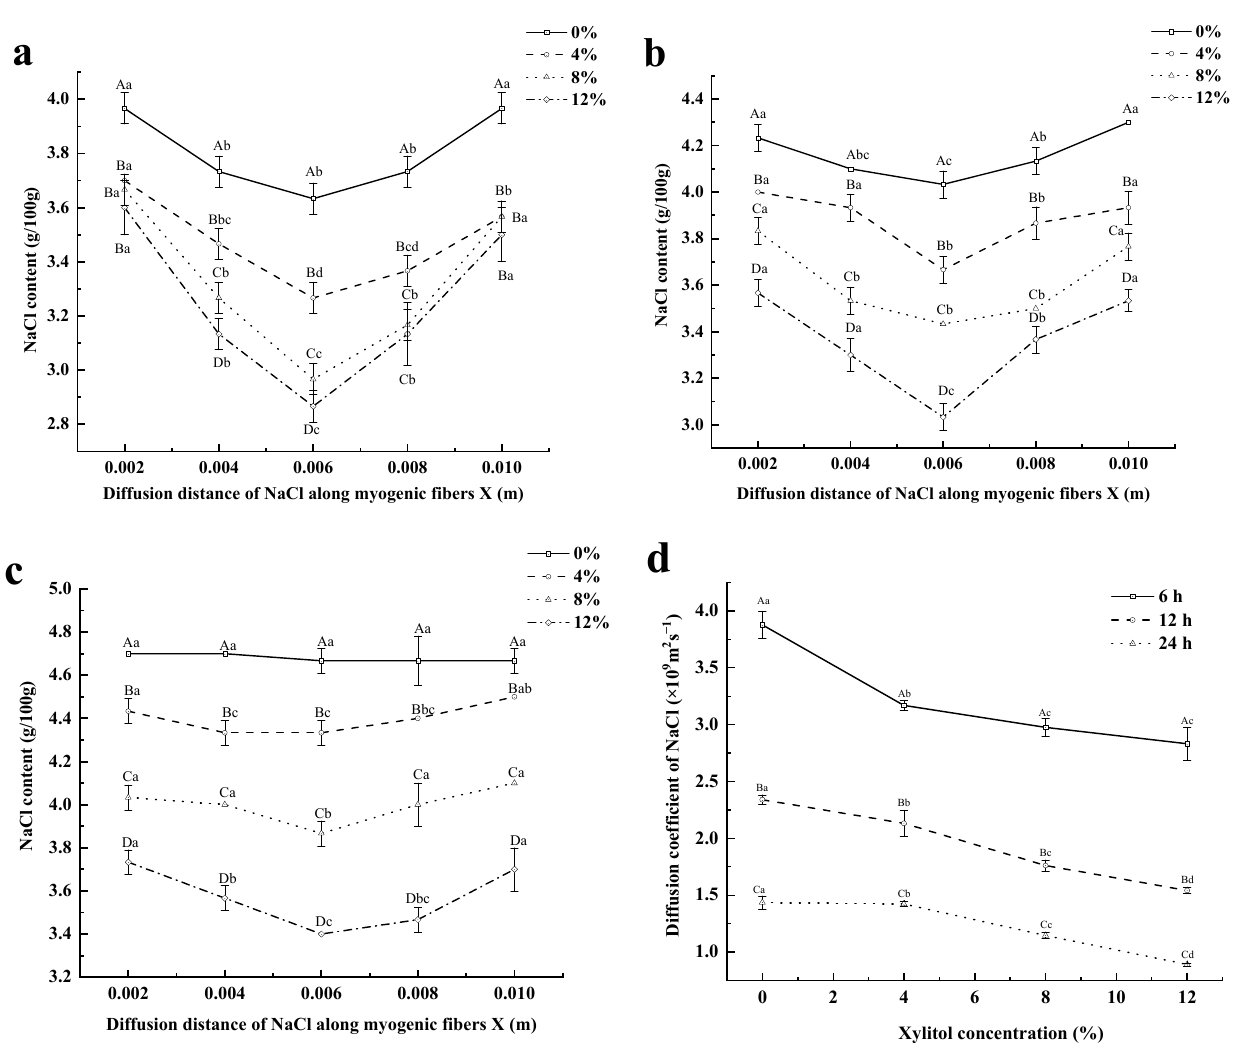
Figure 2. Variation in NaCl content with diffusion distance in pork tenderloin cured for 6 h ( a ),12 h ( b ), and 24 h ( c ) based on different concentrations of xylitol, and the effect of the xylitol concentration and curing time on the diffusion coefficient De of NaCl ( d ) (×10 − 9 m 2 ·s − 1 ). Note: different capital letters indicate significant differences between the treatment groups with different concentrations of xylitol ( a – c ), and curing times ( d ) ( p < 0.05); different small letters indicate significant differences between the treatment groups with different diffusion distances ( a – c ) and different concentrations of xylitol ( d ) ( p < 0.05). Table 1. Kinetic parameters and fitting correlation coefficients of pork tenderloin cured in different xylitol concentrations.